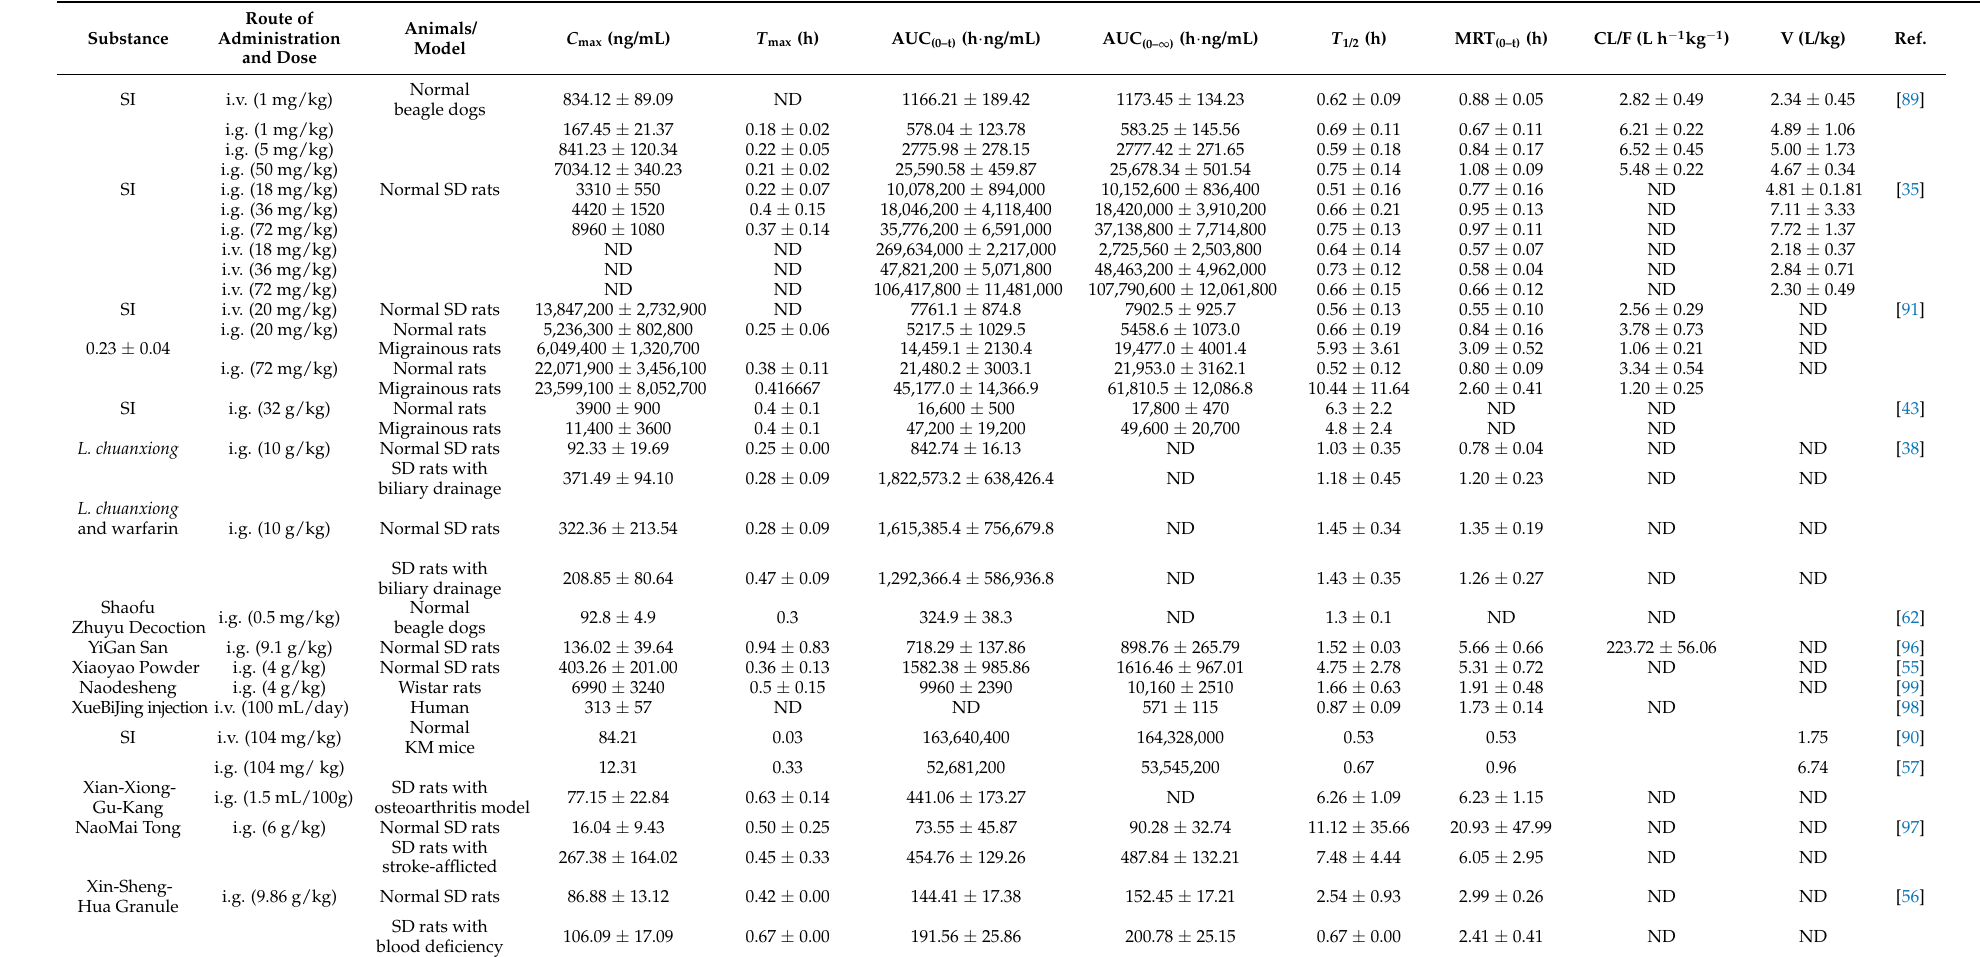
Table 6. The reported pharmacokinetic parameters of